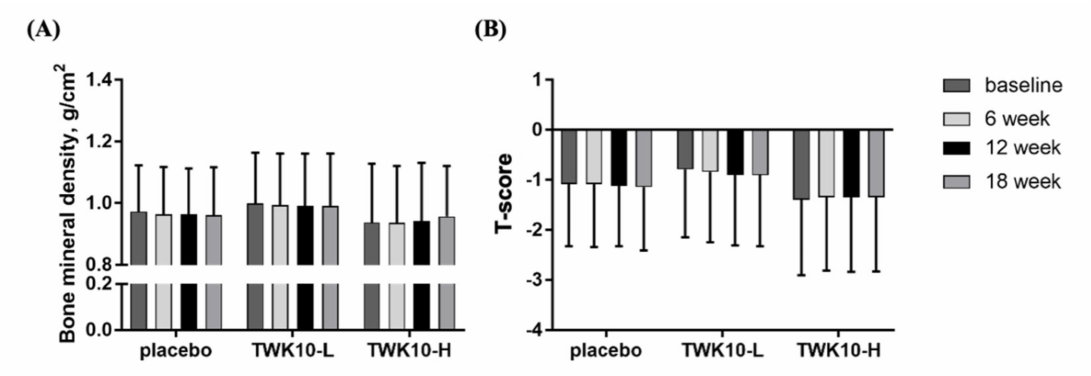
Figure 5. Effect of L. plantarum TWK10 supplementation on the ( A ) bone mineral density (BMD) and ( B ) T-score of elderly participants. Data are expressed as mean ±